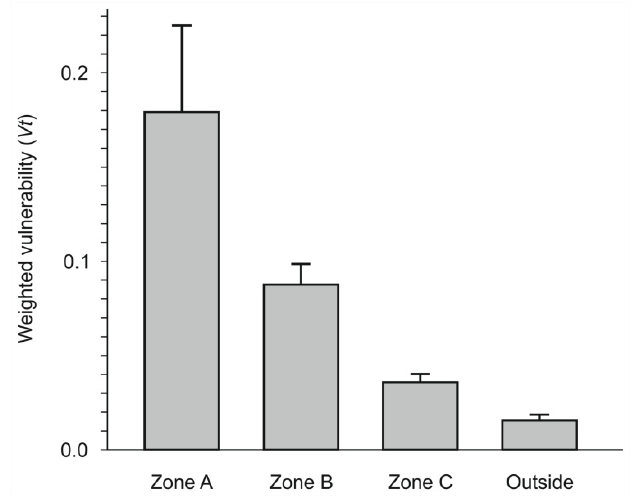
Figure 10. The relation between the value of the marine territory and the zoning imposed onto the MPA. The example refers to the weighted vulnerability of the MPA “Tavolara-Punta Coda